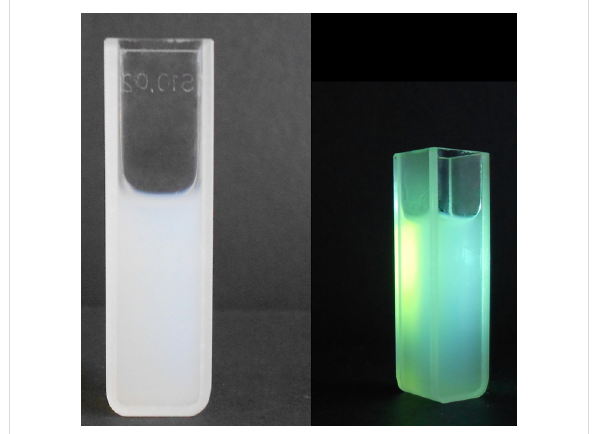
Figure 1: Photograph of colloidal ZnO /PVP nanoparticles (a), and luminescence under UV excitation with a HBO-103W/2 lamp